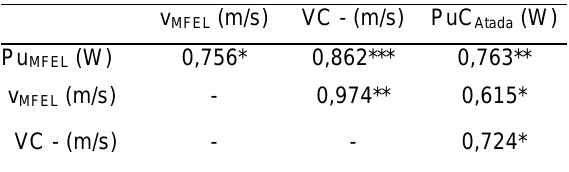
Tabela 2 : Valores do coeficiente de Pearson (r)